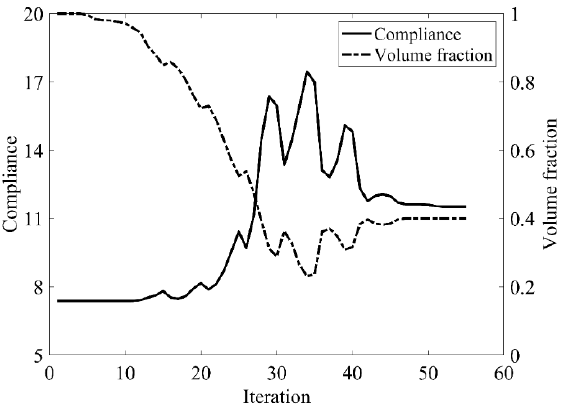
Figure 18. Convergence history of the compliance and the volume fraction for simple bridge beam by CBT level set topology optimization. Table 3. Results for topology optimization of simple bridge